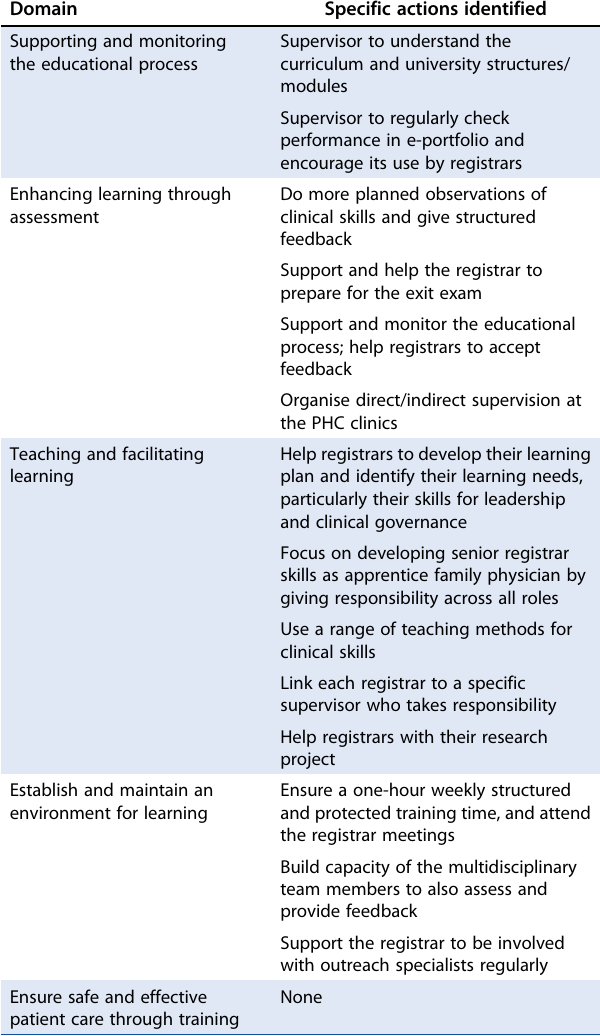
Table 1: Actions identified to develop clinical